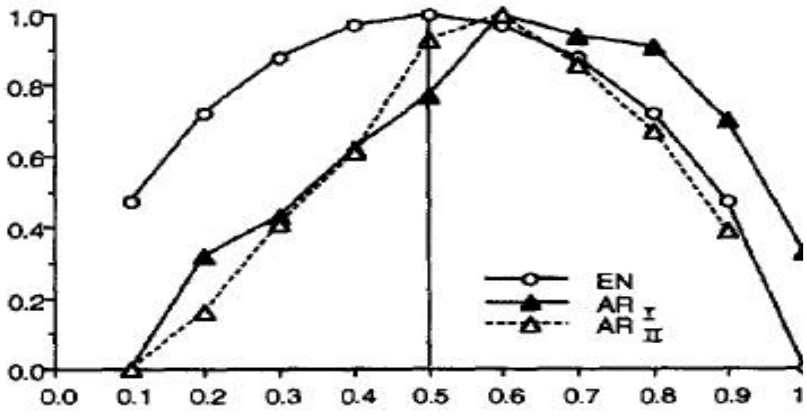
Figure 2. EN, H -entropy vs. AR, apparent randomness. Probability of black-white 2 pixel